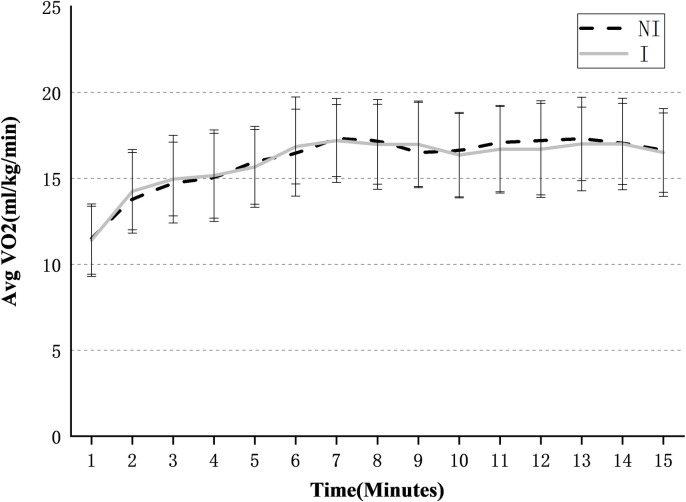
Average relative oxygen consumption.The oxygen consumption of 8 subjects was checked over time under the IPAE(I) and No-IPAE(NI) conditions.